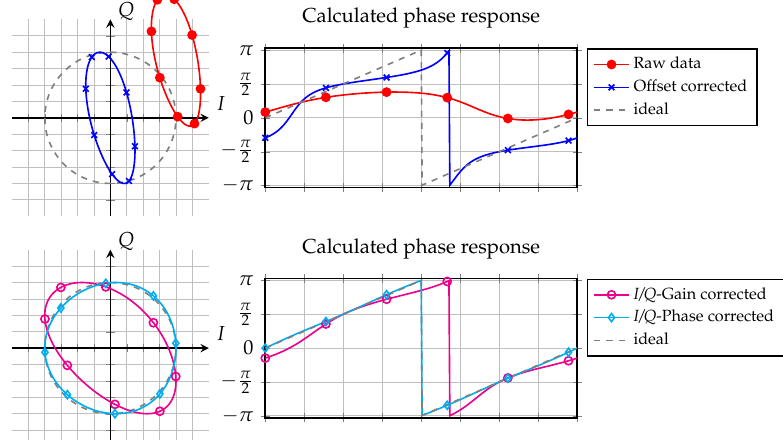
Figure 18. Raw measurement data and calibration steps in in phase/quadrature ( I/Q ) and the phase